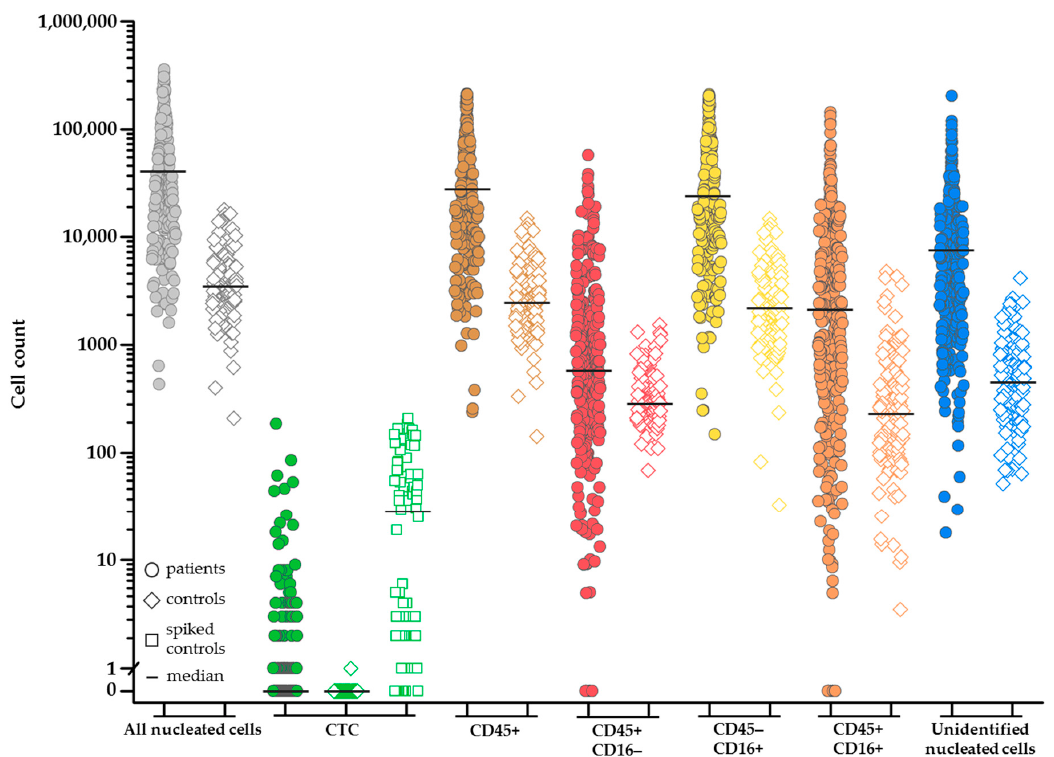
Figure 2. Frequency distribution of the cell populations detected in CellSearch ® and with the addition of the CD16 classification after epithelial cell adhesion molecule (EpCAM) immunomagnetic enrichment of 300 blood samples from 192 non-small cell lung cancer (NSCLC) patients (filled circle) and 127 blood samples from 20 healthy volunteers (open diamond). Healthy volunteer samples spiked with cell line cells ( n = 88) are indicated with an open square. Cell populations: All nucleated cells (grey), circulating tumor cells (CTC) (green), CD45+ leukocytes (brown), CD45+/CD16- leukocytes (red), CD45-/CD16+ leukocytes (yellow), CD45+/CD16+ leukocytes (orange), and unidentified cells (blue). The differences in cell count between the NSCLC patients and healthy volunteers in the same cell classification is significant for all subclasses ( p < 0.001). Samples from healthy volunteers were not spiked (diamond symbol, n = 39; median 0 CTC) or spiked (square symbol) with cancer cell lines PC3 ( n = 47; median 63 CTC; 1.0 × 10 4 EpCAM antigens) and NCI-H460 ( n = 41; median 1 CTC; 1.4 × 10 2 EpCAM antigens).